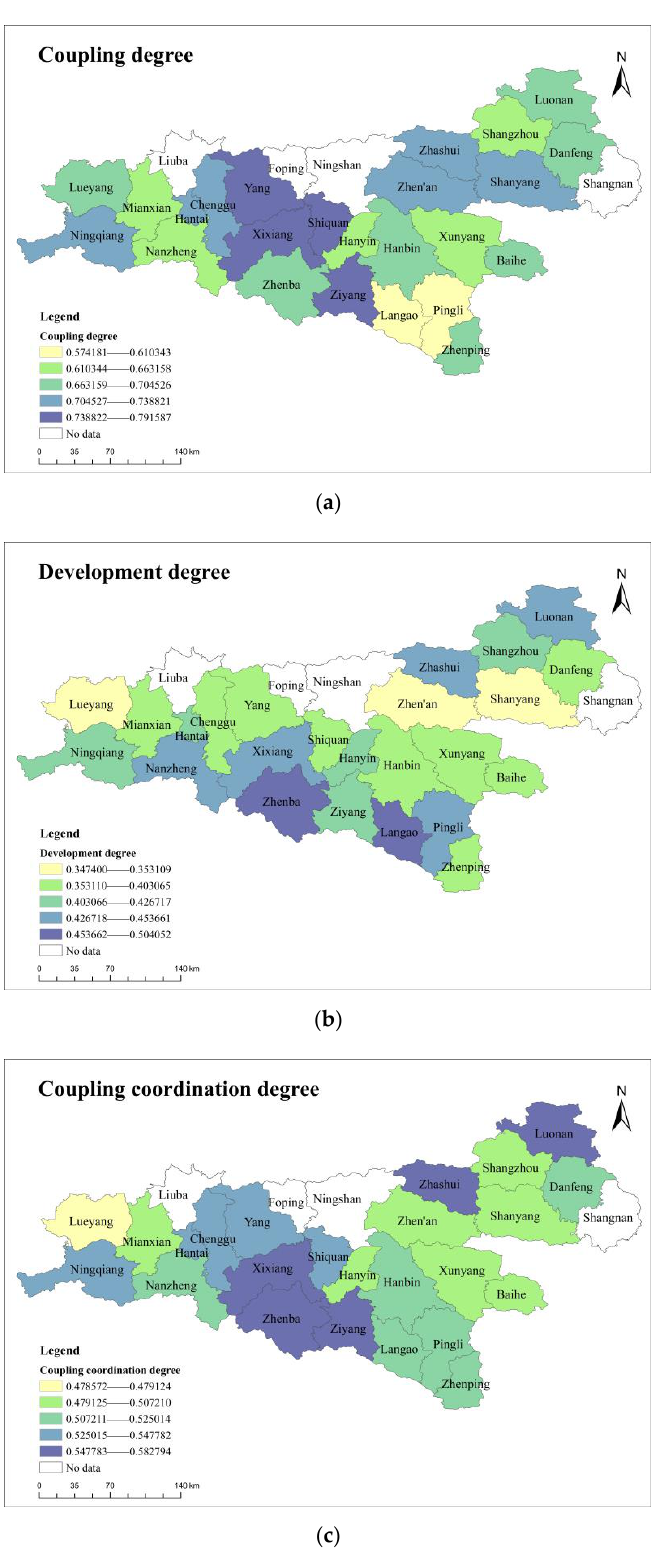
Figure 3. Spatial distribution of the coupling coordination relationship between household livelihood efficiency and land use in different regions (districts and counties). Coupling degree ( a ), development degree ( b ), coupling coordination degree ( c